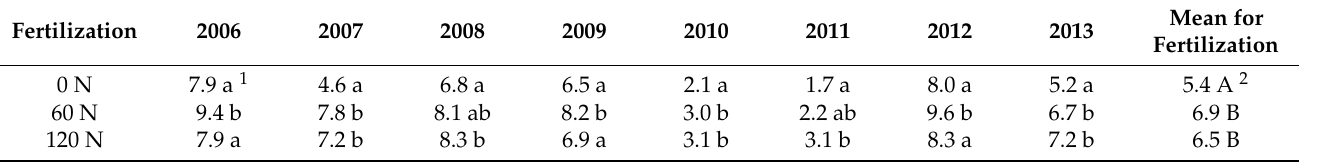
Table 4. Yield of sour cherries of the ‘Łut ó wka’ cultivar in the years 2006–2013 depending on the year and fertilization (kg · tree − 1 ).